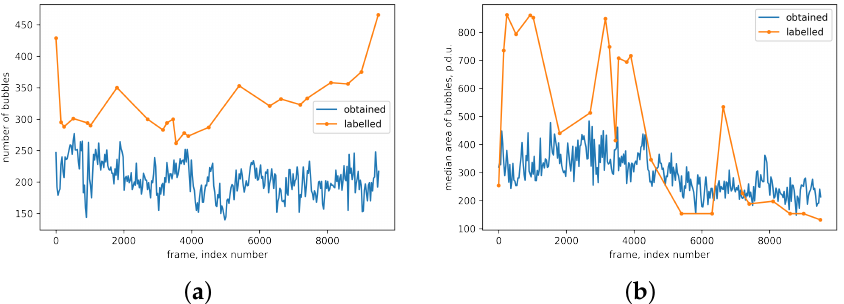
Figure 19. Number ( a ) and median area ( b ) of detected (blue) and labeled (orange) bubbles. One can see that the CCV method produces more stable results that manual labeling since a person labeled all bubbles including out-of-focus ones. It might bring additional factors related to the movement of more distant bubbles that the NN method did not detect. Furthermore, note the lack of an obvious explicit difference between clear and blurred bubbles increases the labeling error.